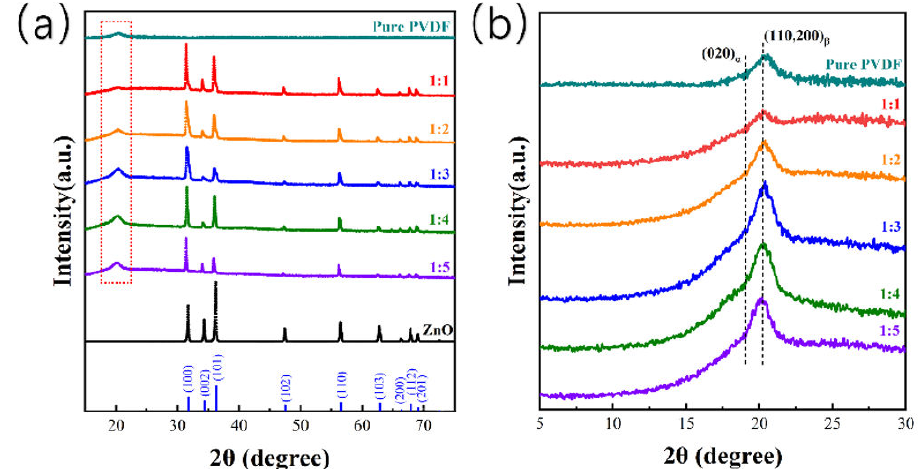
Figure 4. XRD patterns used to investigate the crystal phase composition. ( a ) XRD patterns of the electrospinning pure PVDF membrane, and the tetrapodal ZnO and ZnO@PVDF composite membranes with mass ratios of ZnO:PVDF = 1:1, 1:2, 1:3, 1:4, and 1:5, respectively. ( b ) Enlarged view of the red dotted box in ( a